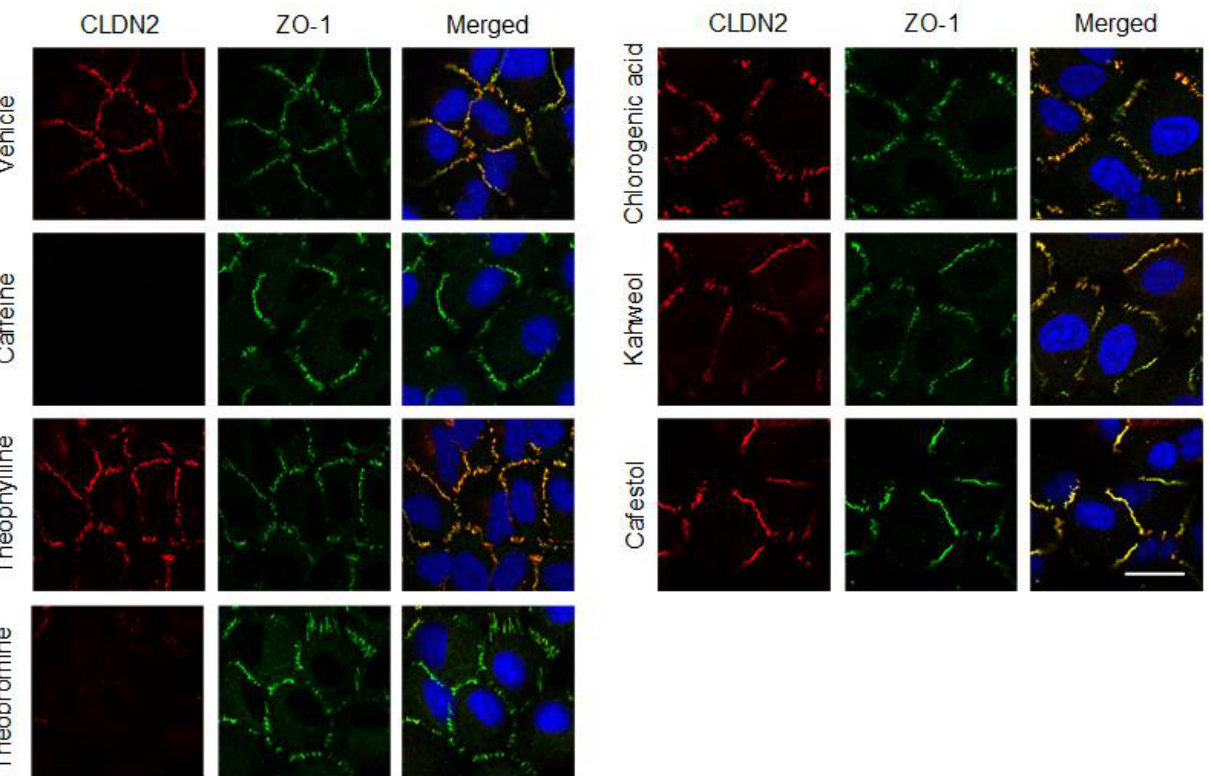
Figure 3. Effects of coffee ingredients on the cellular localization of CLDN2 and ZO-1. The cellular localization of CLDN2 and ZO-1 is indicated as red and green fluorescence signals, respectively. Merged images with DAPI (blue, nuclear marker) are shown on the right. The scale bar indicates 10 μ m.